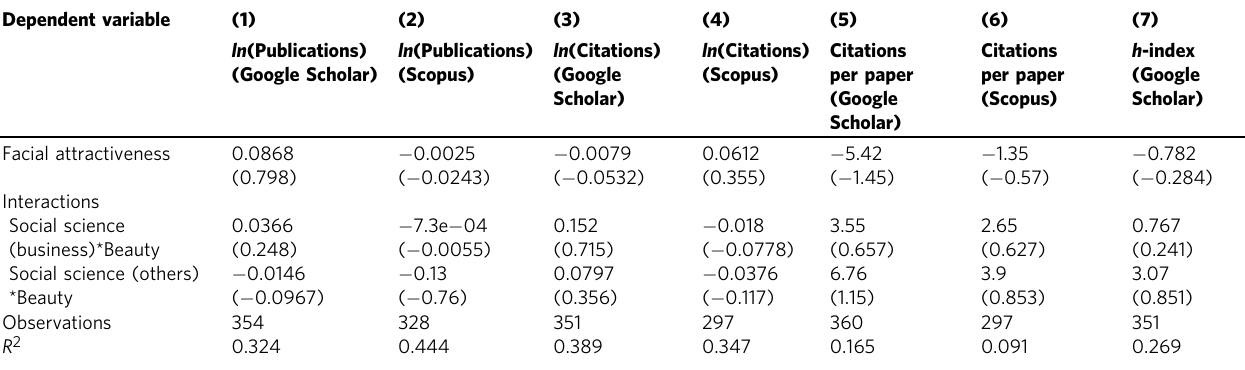
Table 2 Facial attractiveness and academic performance: between- fi eld comparison.